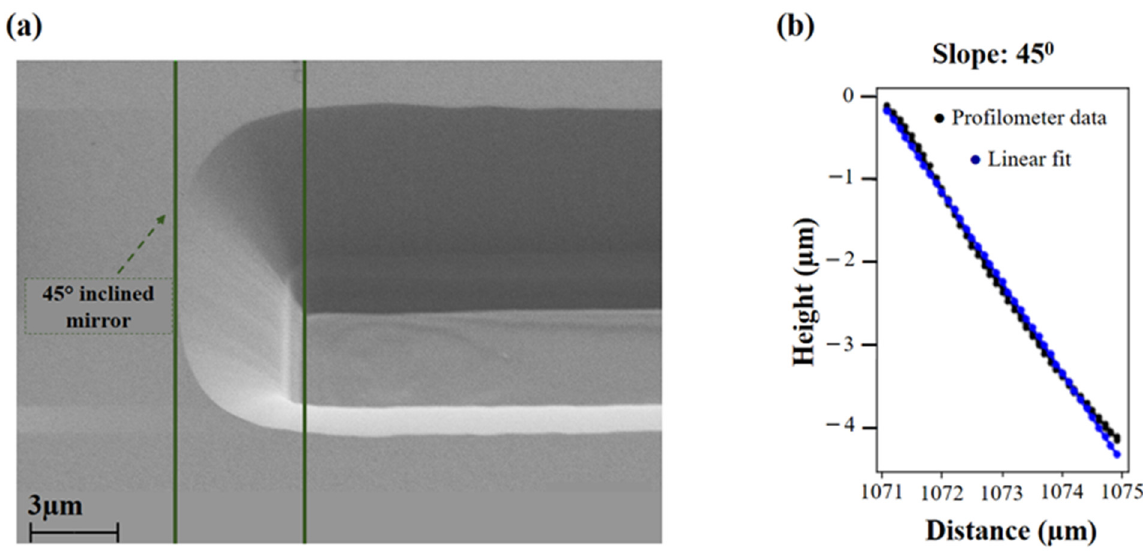
Figure 6. ( a ) Scanning Electron Microscope (SEM) image of a sample with etched 45 ◦ slopes fabricated by mask-aligner technology. ( b ) Stylus profilometer scan of the edge confirming the slope angle of figure ( a ).